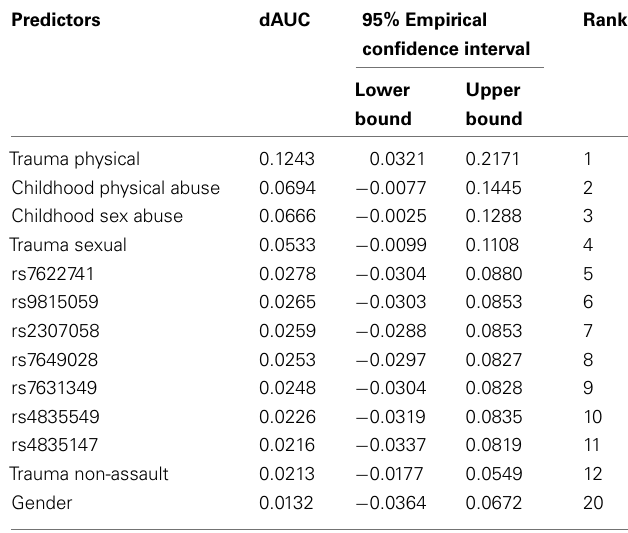
Table 2 | Individual contribution of top-ranked predictors to cocaine dependence risk